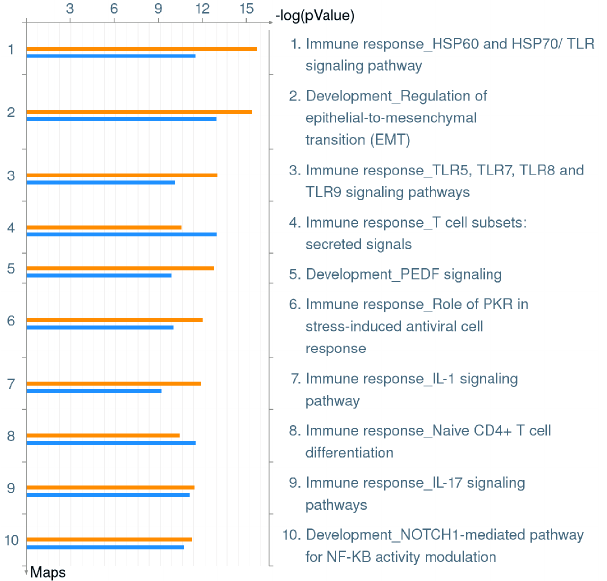
Figure 1. Top 10 Pathway Maps up-regulated in hMDMs upon infection by L. pneumophila . Metacore analysis of triplicate microarrays of wild type strain and ankB mutant-infected hMDMs at 8 h post-infection showing the top 10 Pathway Maps. The upper orange bar of each column represents wild type-infected hMDMs while the lower blue bar represents the ankB mutant-infected